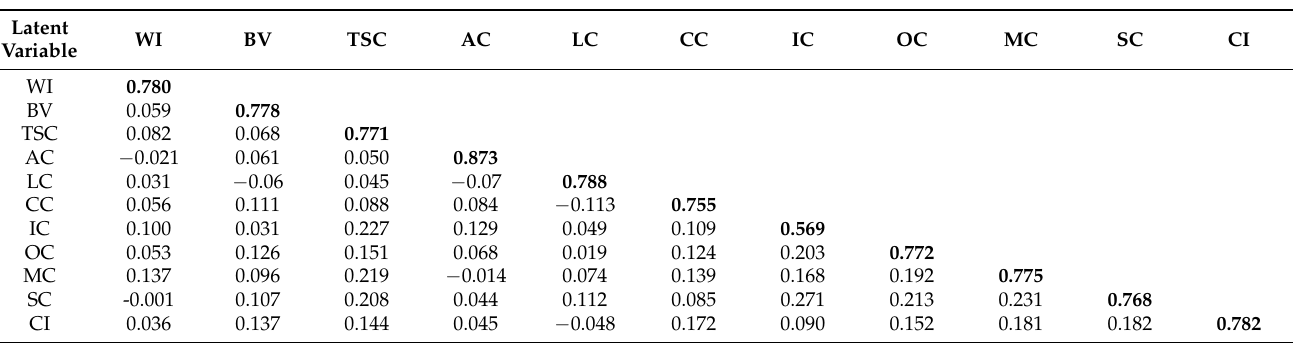
Table 5. The discriminant validity.